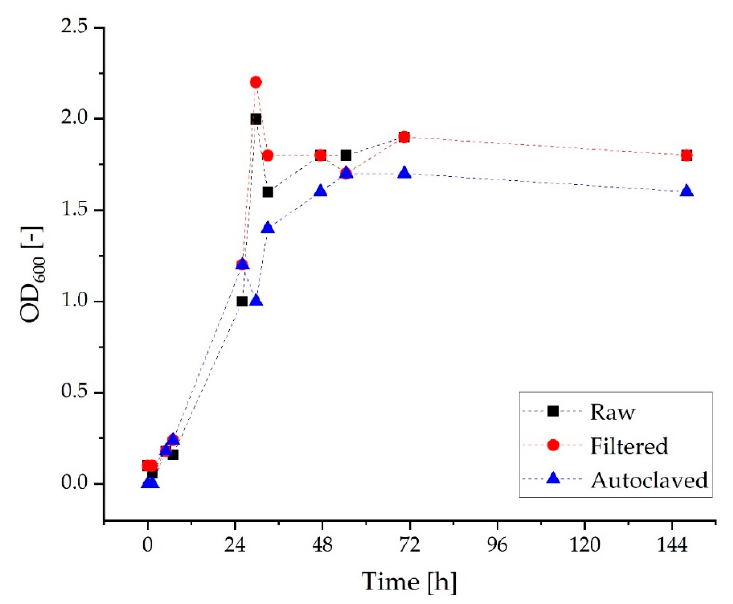
Figure 2. Growth curves of C. necator pKR-hum in 30% raw, 30% sterile-filtered, and 30% autoclaved grass juice from the juice extractor diluted in MMasy (n = 1, dashed line serves as a guide to the eye).